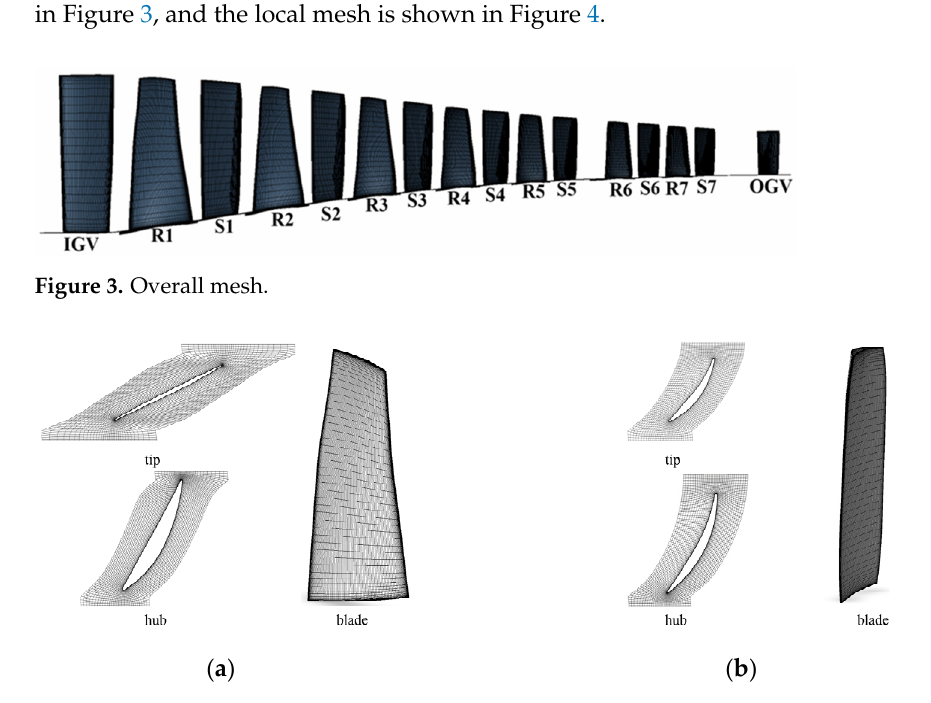
Figure 4. Local mesh of R1 and S1. ( a ) R1; ( b ) S1.